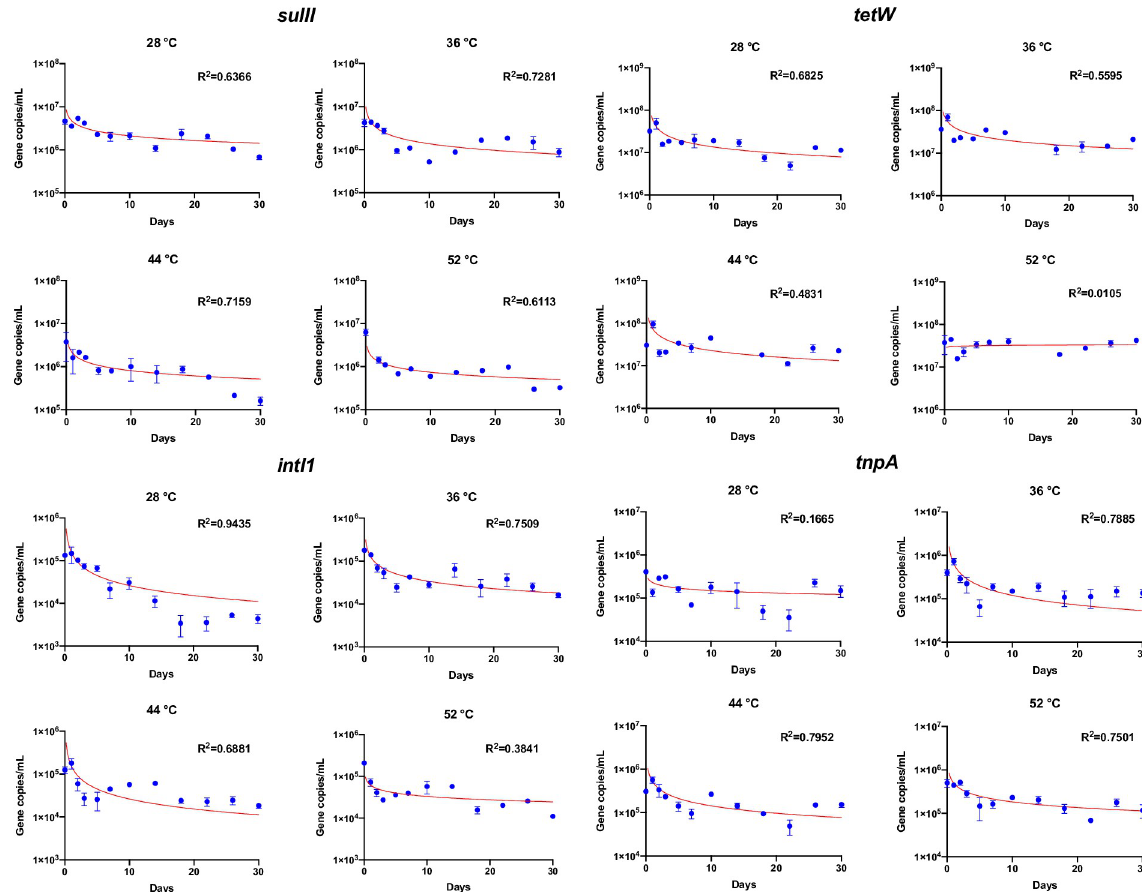
Fig 5. Modelling fit of sulII , tetW , intI1 , and tnpA . Bars represent standard errors. Blue dots represent the mean value of triplicate reactors under each temperature. Solid red lines represent the best fit of the data to a modified Collins–Selleck model. The model coefficients are shown in Table